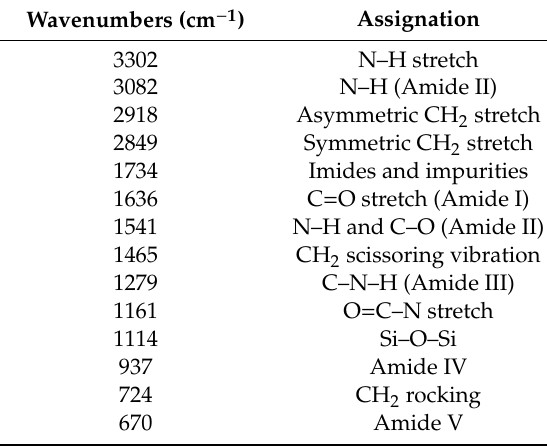
Figure 1. TGA curves of the non-exposed coatings. Table 1. IR absorption bands assignations